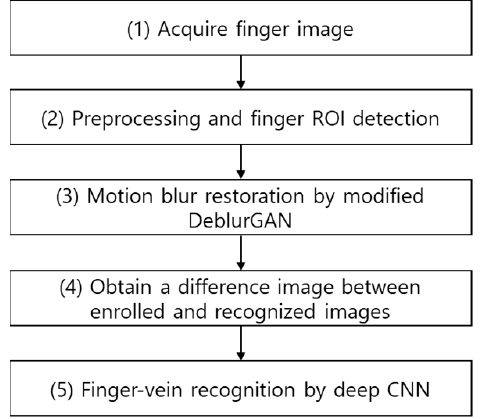
Figure 1. Flowchart of the proposed method.